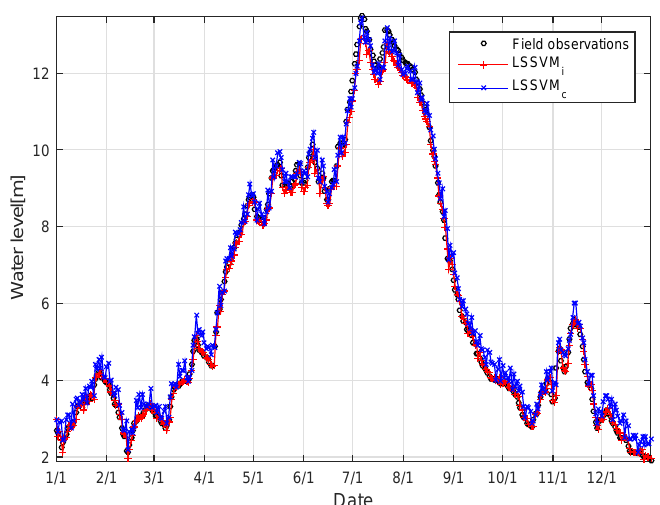
Figure 4. Comparison between model predictions and field observations at Jianli (Year 2016).